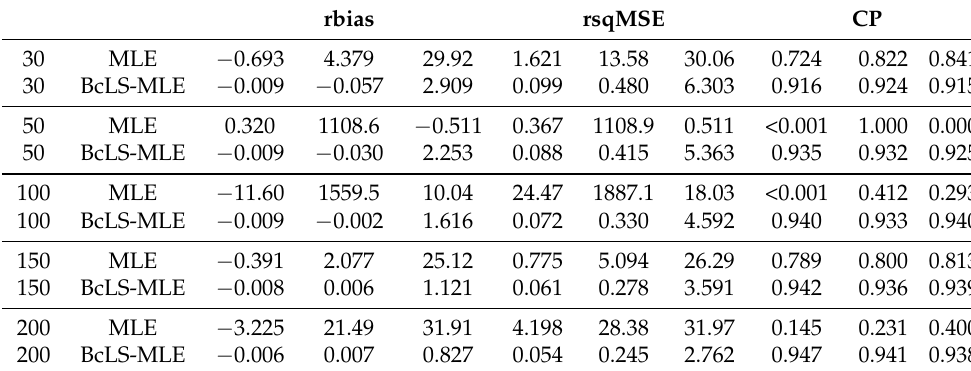
Table 8. The rbias and rsqMSEs of the BcLS-MLE and MLE, and the CP of S ( y 0 | Θ ) for LPN ( Θ ) with ξ = 10, σ = 0.6, γ = 3, and 1 − α = 0.95.